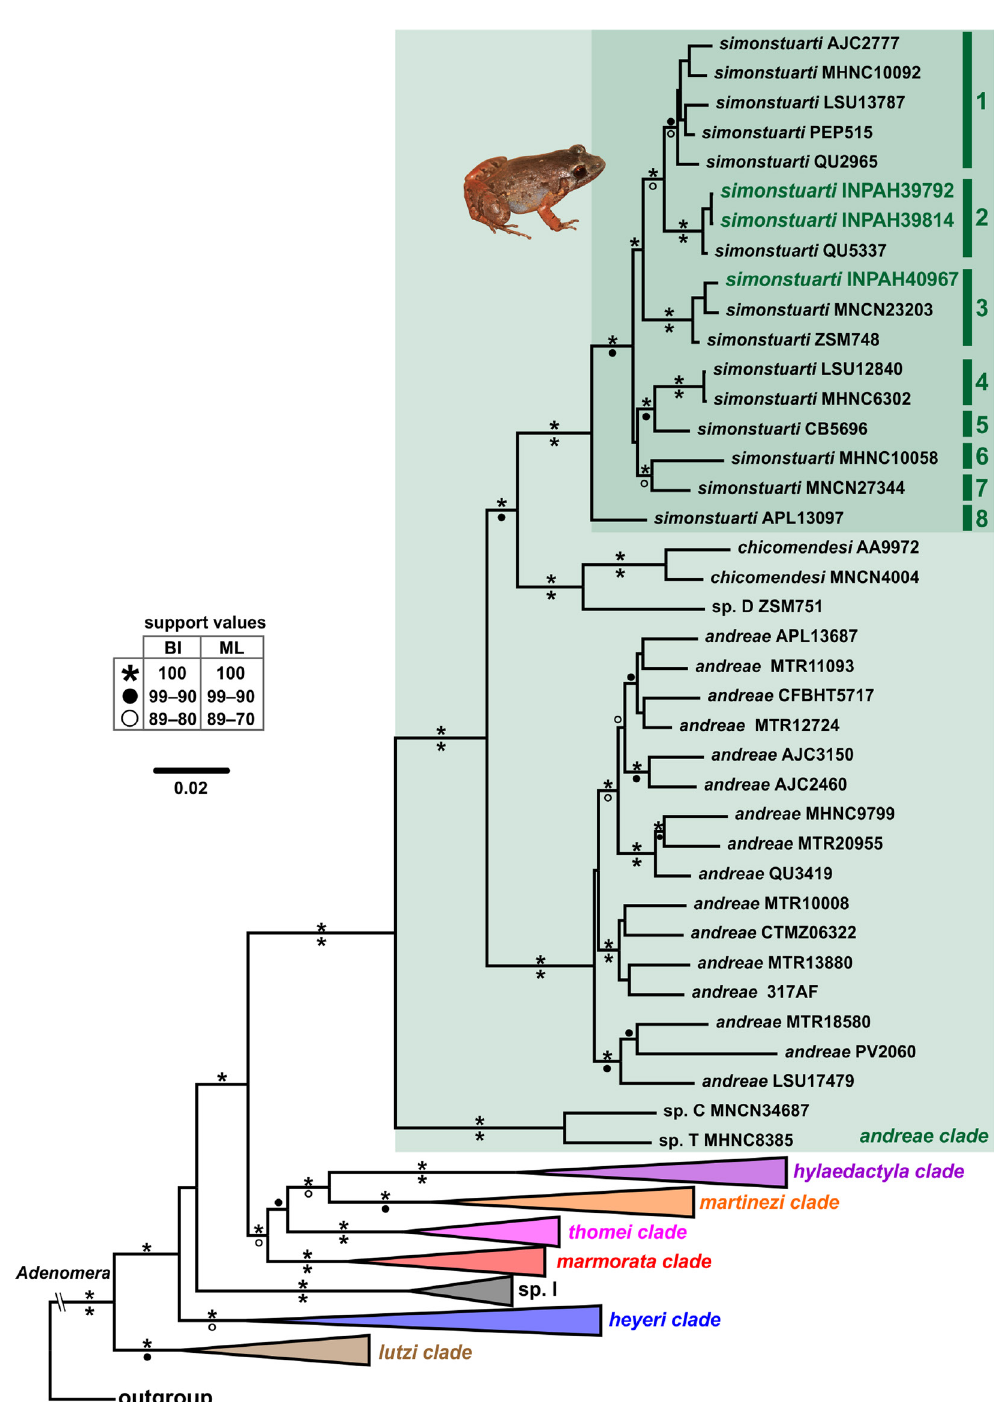
Fig. 1. Bayesian phylogenetic tree of Adenomera Steindachner, 1867 inferred from a concatenated dataset of four genes (two mitochondrial + two nuclear), showing the eight major clades delimited by colors. The emphasis on the diversification within the A. simonstuarti species complex shows a deep genetic divergence, with eight distinct lineages (see Fig. 2 for geographic distribution). Symbols above branches indicate posterior probabilities of Bayesian inference (BI) and those below branches indicate bootstraps of maximum likelihood inference (ML). Low support values (BI < 80 and ML < 70) were omitted. Branch scale is indicated in number of substitution per